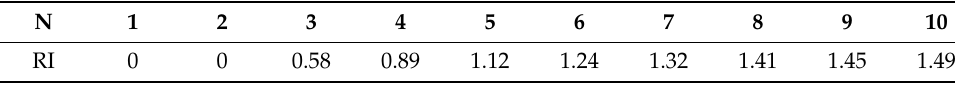
Table 2. Tabulated standards of N for Saaty’s ratio